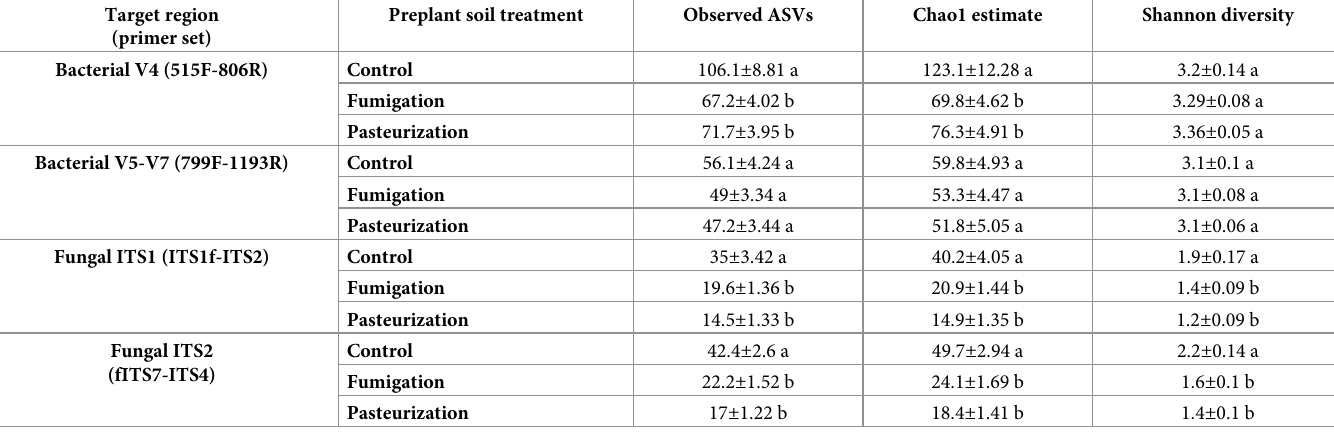
Table 1. Richness and diversity of bacterial and fungal community rRNA gene amplicon libraries from roots as a function of primer set and preplant soil treatment a . Target region (primer set)